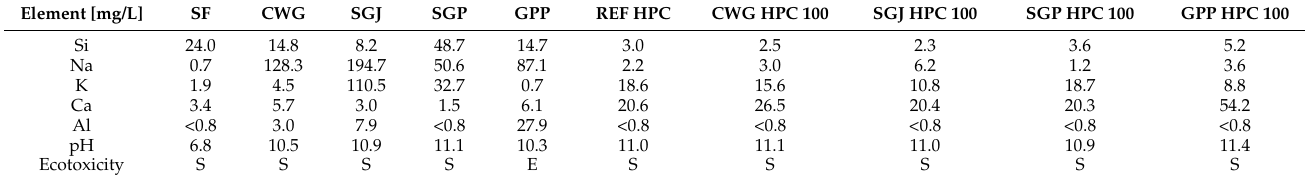
Table 2. Chemical and ecotoxicological properties of GP and HPC leachates. S—safe,